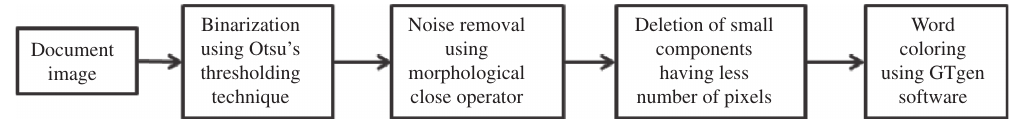
Figure 2: Block Diagram of GT Image